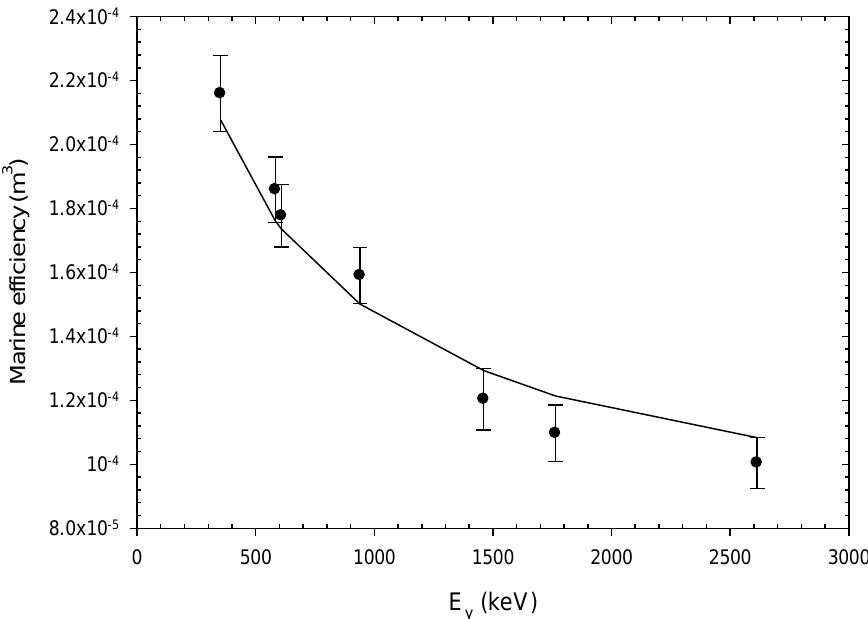
Figure 5. The measured and simulated marine efficiency values from the threshold energy to 2614 keV. The filled circles represent the experimental values while the line the theoretical reproduction values of the marine efficiency.